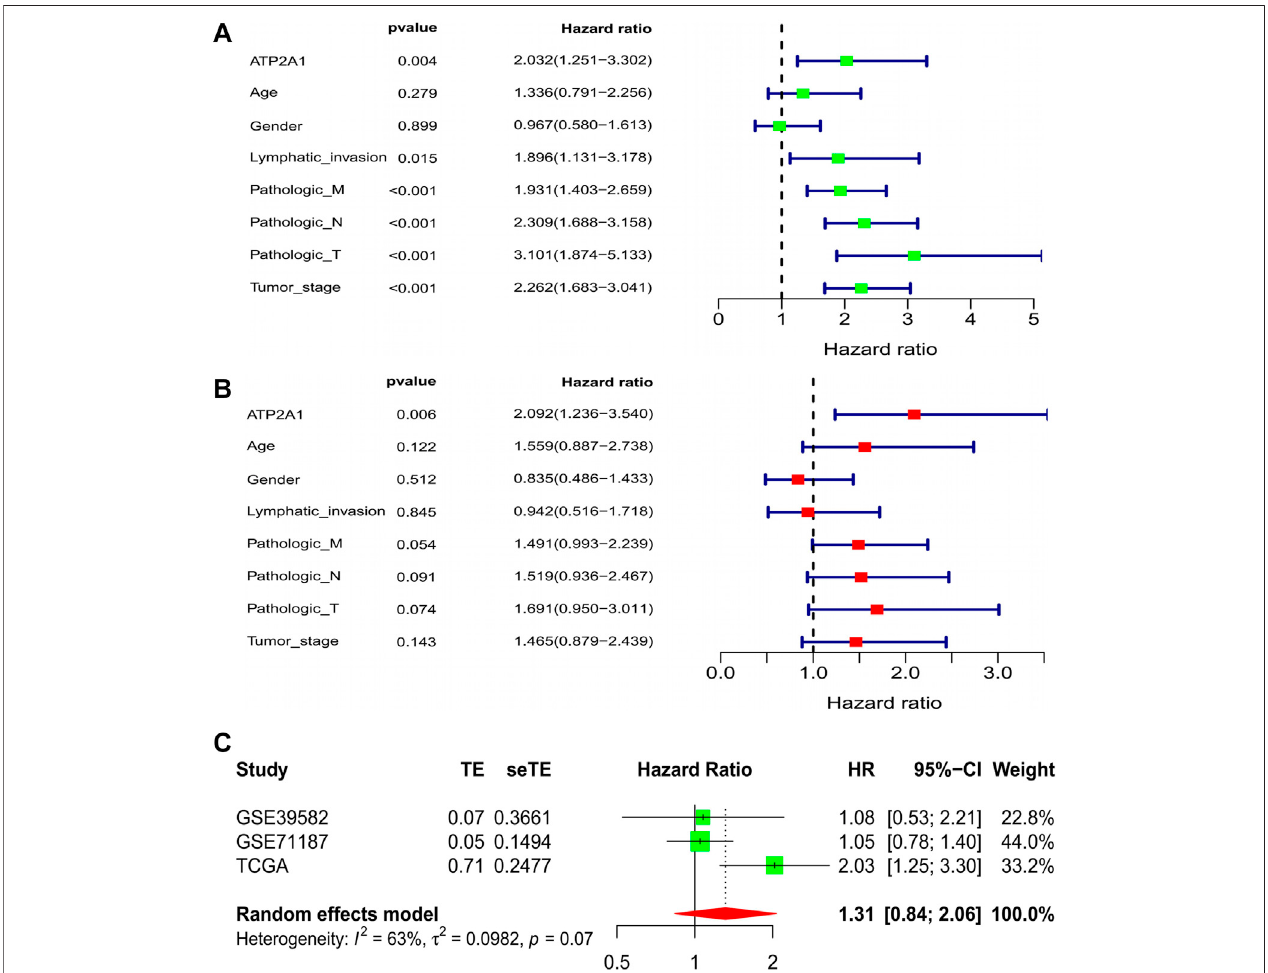
FIGURE 2 | Cox regression model and meta-analysis of ATP2A1 expression in CRCs. (A) Univariate analysis of ATP2A1 expression and clinical related factors [ ATP2A1 , p = 0.004, HR = 2.032 (95%CI (1.251-3.302))]. (B) Multivariated analysis of ATP2A1 expression and clinical related factors [ ATP2A1 , p = 0.006, HR = 2.092 (95%CI (1.236-3.540))]. (C) Forest plots of meta-analysis of ATP2A1 effect on prognosis from multiple data sets [HR = 1.31 (95%CI